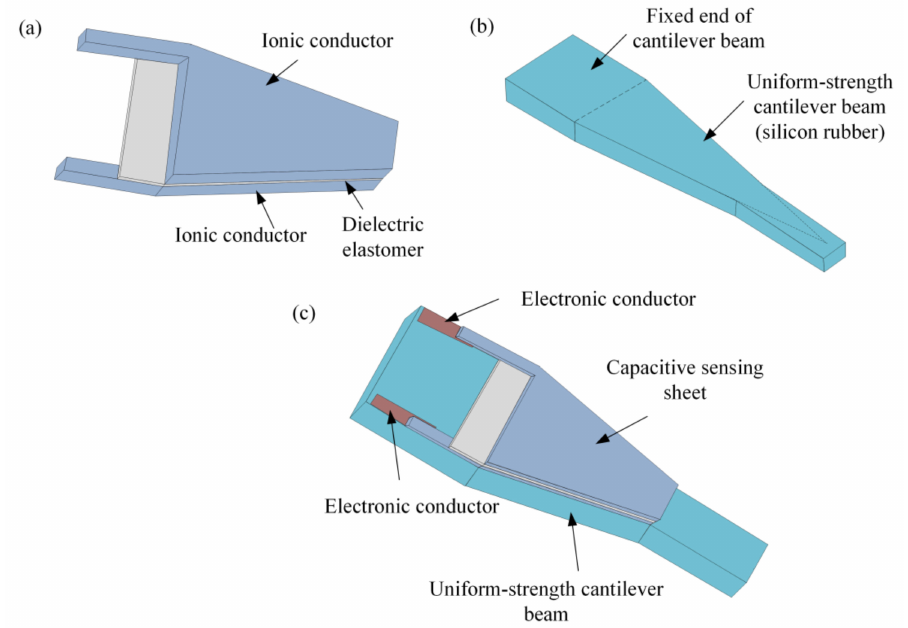
Figure 1. Schematic diagram of the tactile sensor where ( a ) is the capacitive sensing sheet, ( b ) is the uniform- strength cantilever beam, and ( c ) is the tactile sensor by assembly of the capacitive sensing sheet to the uniform-strength cantilever